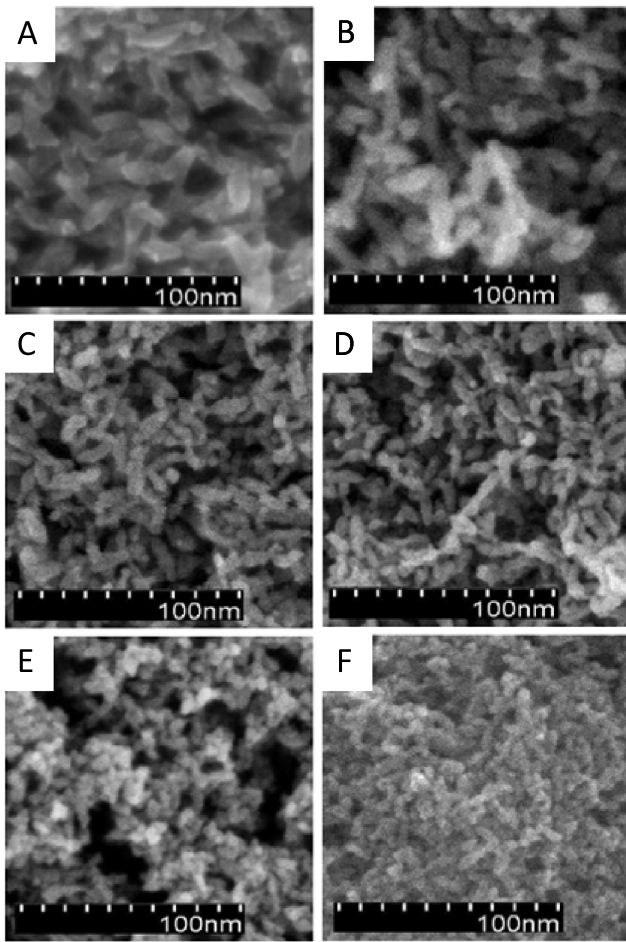
Fig. 3. FESEM of TiO 2 nanorice structures grown on ITO sub- strate prepared using different HMT concentrations, namely 0.03 (A), 0.04 (B), 0.05 (C), 0.06 (D), 0.07 (E) and 0.08 M (F). (NH 4 ) 2 TiF 6 or (AHT) is fixed at 0.05 M. The growth time is 5 min.